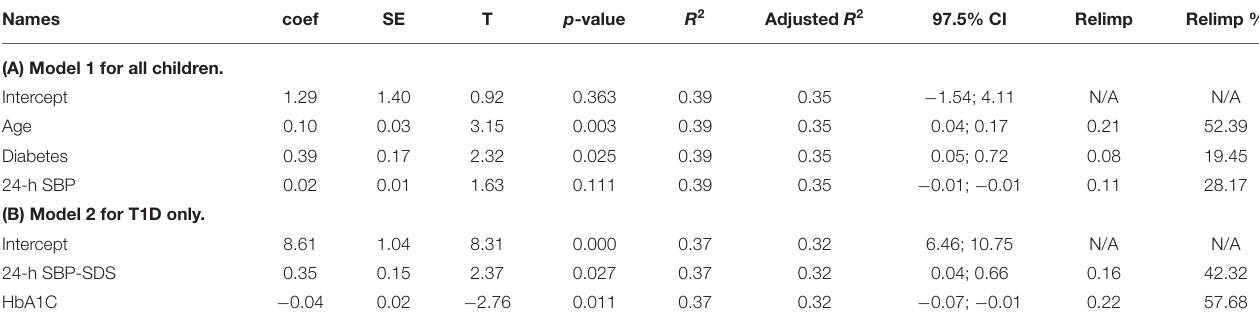
TABLE 4 | Multivariate